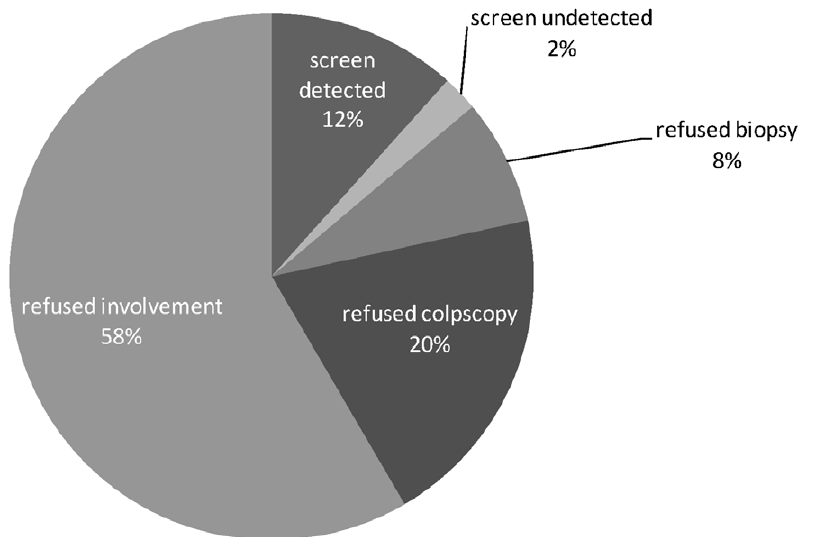
Figure 2. Estimated proportion of cases of CIN2 + observed and estimated via population weighting for verification bias adjustment. Screen detected indicates proportion of cases of CIN2 + detected by hc2, and screen undetected indicates the proportion of CIN2 + cases detected through the screening program, but missed by hc2. Refused biopsy indicates the proportion of CIN2 + cases estimated among those who refused biopsy, refused colposcopy indicates the proportion of CIN2 + cases estimated among those who screened positive, but refused colposcopic exam, and refused involvement indicates the proportion of CIN2 + cases estimated among those who refused participation in the program (i.e., not screened).